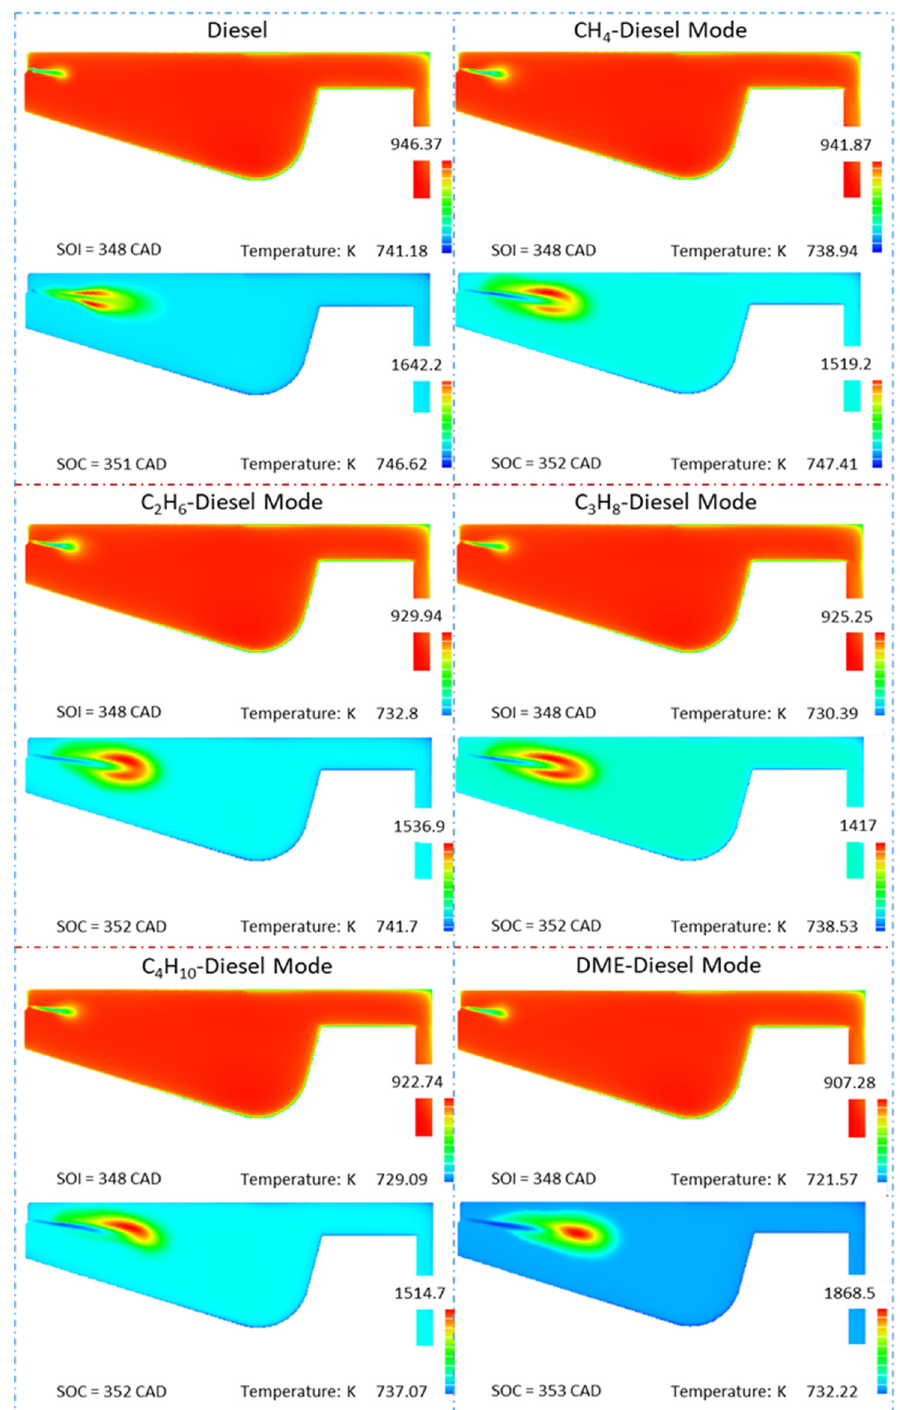
Figure 17. Spatial in-cylinder temperature contours at SOI and SOC crank angle degrees. The SOI of diesel in the diesel mode and pilot fuel (diesel also) in the DF mode are 348 CAD. The diesel fuel could not ignite as soon as it was injected into the engine combustion chamber; thus, the temperature of the fuel beam (shown in green and yellow) was much lower than the in-cylinder temperature of the engine (shown in dark red). After a few milliseconds, after having received enough heat to evaporate and raise the temperature up to the flash point of the fuel, the diesel oil begins to self-ignite, causing the temperature at the core of the fuel beam to dramatically increase (shown in dark red), marking the start of the combustion of the fuel in the engine cylinder. As soon as the fuel burns,